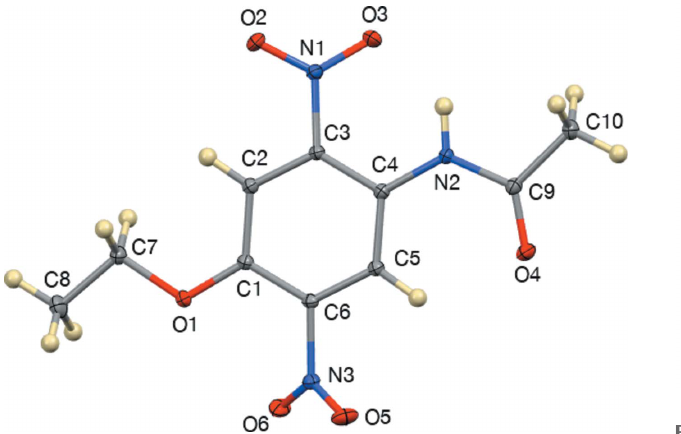
Figure 1 The title molecule showing 50% displacement